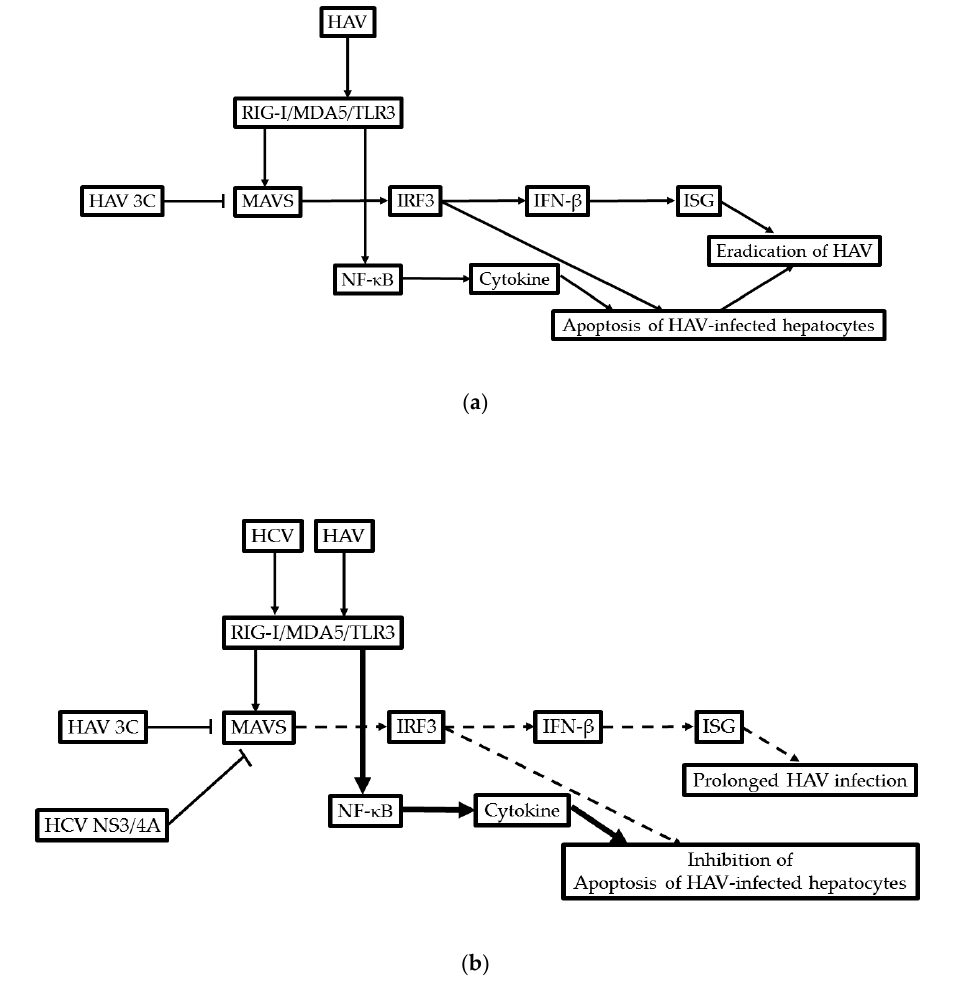
Figure 2. Possible molecular mechanism of the development of acute-on-chronic liver failure (ACLF) in patients coinfected with hepatitis A virus (HAV) and HCV. ( a ) Only HAV infection; ( b ) coinfection HAV and HCV. RIG-I, retinoic acid-inducible gene-I; MDA-5, melanoma differentiation associated gene 5; TLR3, toll-like receptor 3; MAVS, mitochondrial antiviral signaling protein; IRF3, interferon regulatory factor 3; IFN, interferon; ISG, interferon-stimulated gene; NF- κ B, nuclear factor kappa B subunit 1.